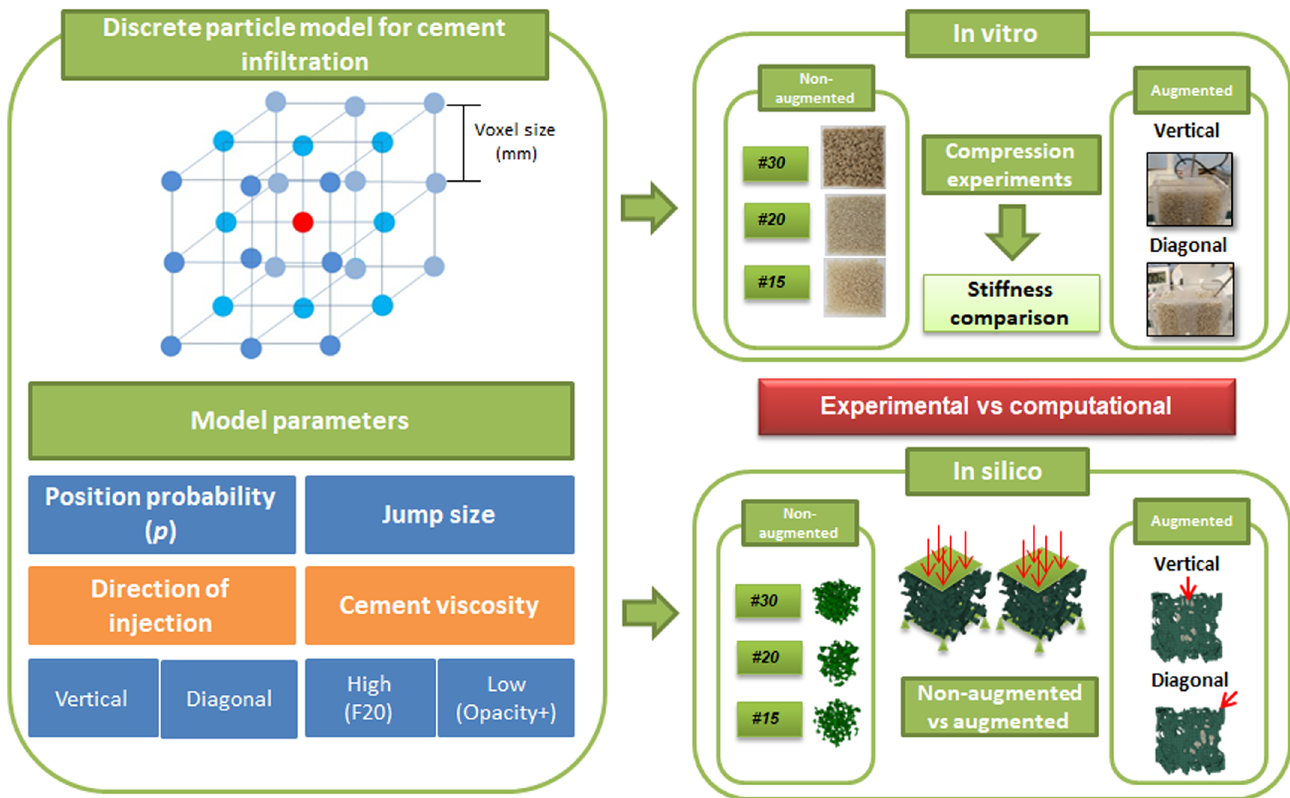
Fig 1. Workflow for the in vitro and in silico characterization of open-cell structures: Non-augmented vs. augmented with cement.